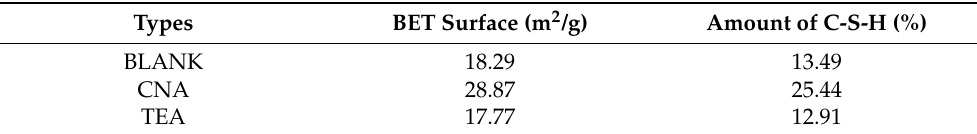
Figure 7. 1-day BET specific surface area of cement hydration products with nothing ( a ), CNA ( b ) and TEA ( c ). Table 4. The C-S-H content calculation results and BET data statistics of each group.